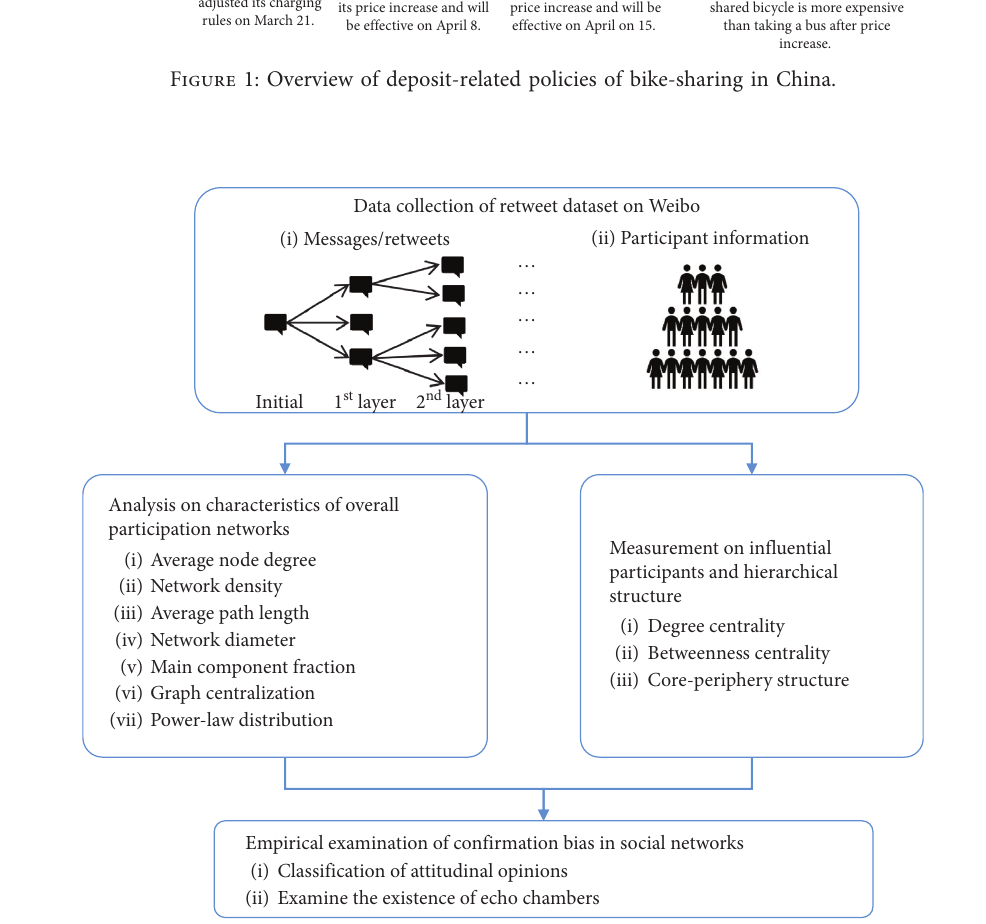
Figure 2: Research analysis framework in this